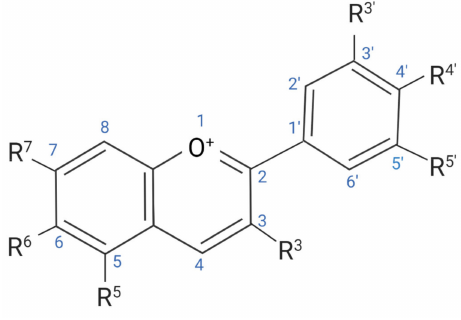
Figure 1. Basic chemical structure of